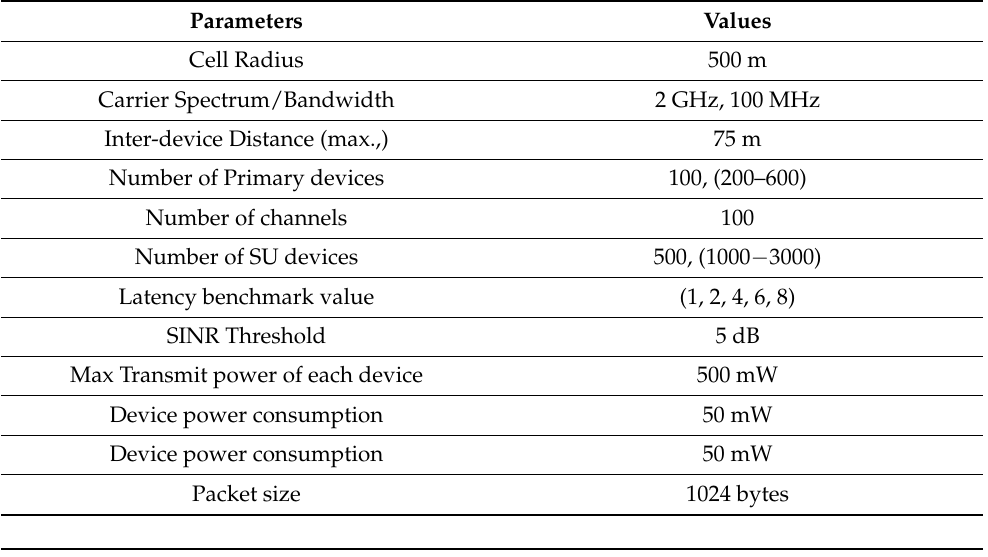
Table 1. Simulation Parameters.